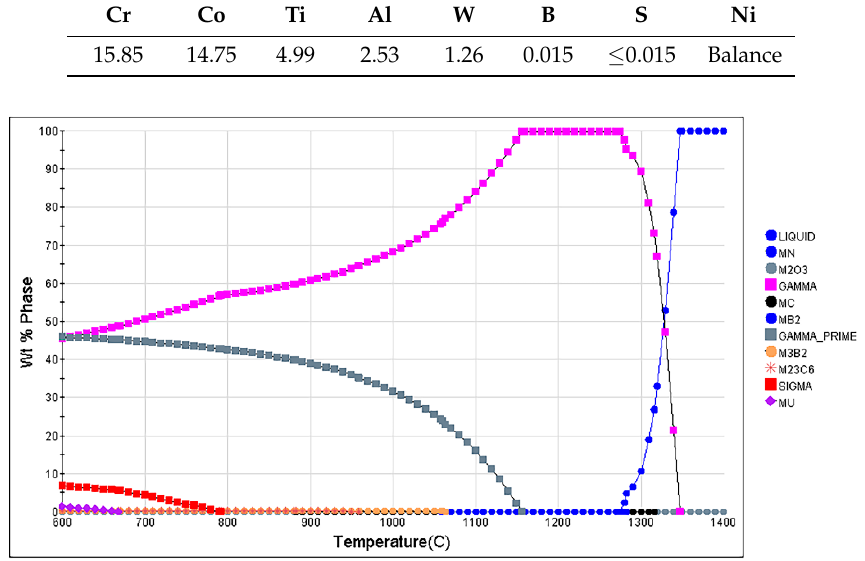
Table 1. Chemical composition of the GH4720Li superalloy (wt%).